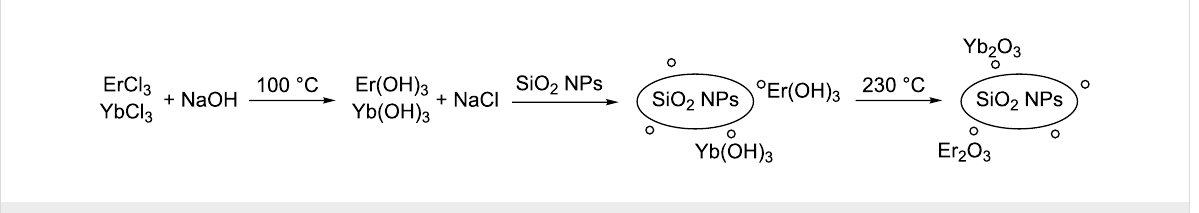
Figure 1: The outline of the synthesis process of Er/Yb oxide